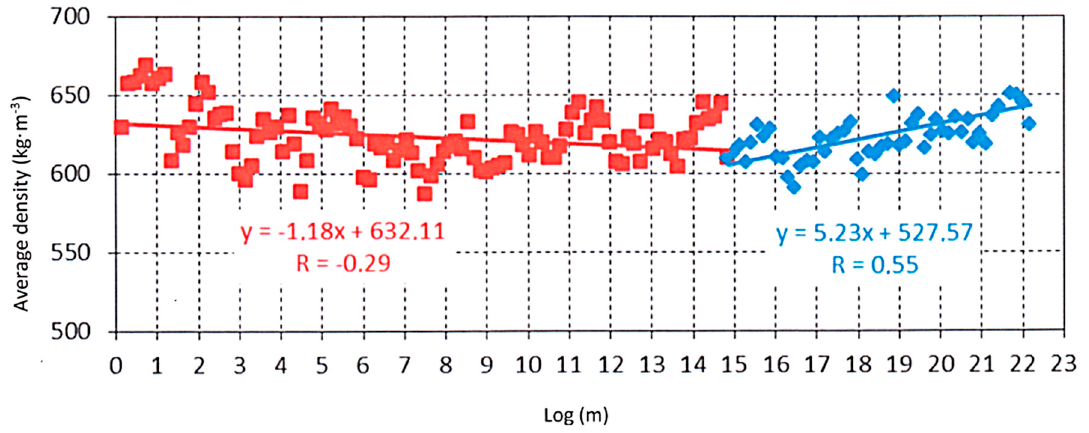
Figure 7. Distribution of average densities on the longitudinal section of a birch log.